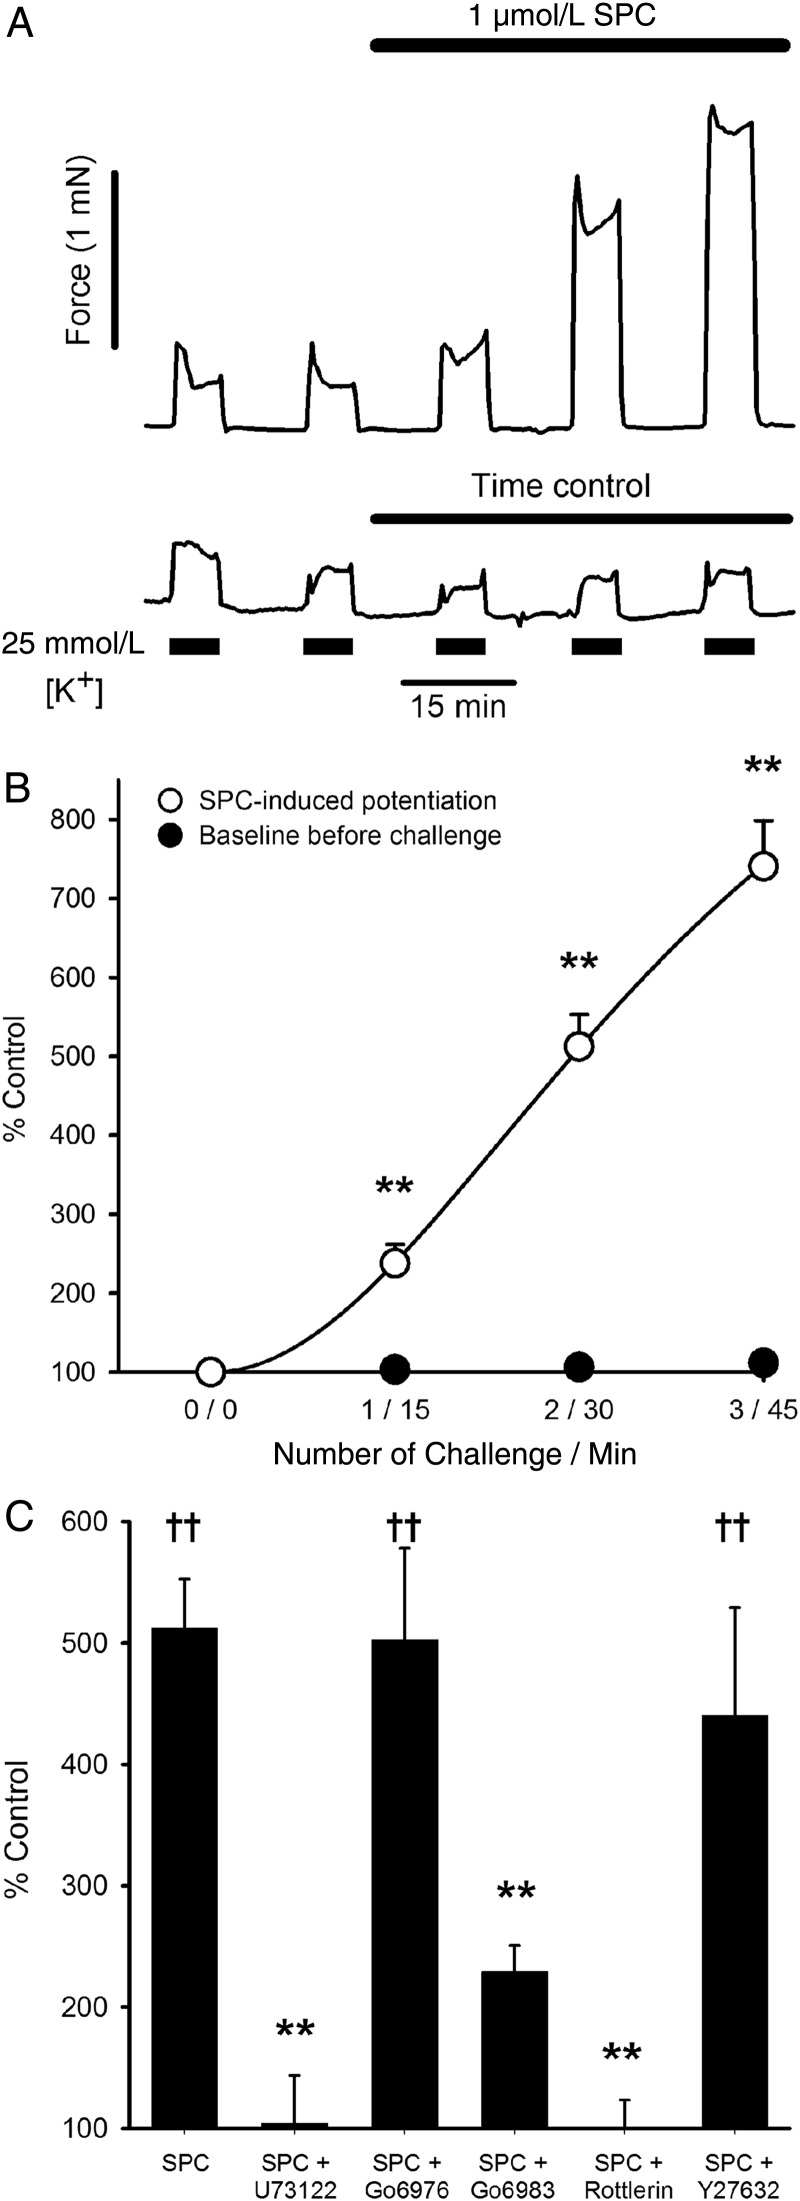
SPC-induced potentiation of tension development in MA. (A) Typical recordings of tension developed in rat MA to 5 min challenges with PSS containing 25 mmol/L [K+], demonstrating strong potentiation of contraction following addition of 1 µmol/L SPC compared with time control. (B) Mean data from 31 MAs (24 rats). Open symbols represent an increase in tension over control response (challenge 0 at time 0, i.e. 0 / 0) following addition of SPC. Filled symbols represent tension immediately preceding each depolarizing challenge, demonstrating a stable baseline. Bars = SEM, where not shown, smaller than symbol. ** P < 0.001 vs. control; repeated measures (RM) ANOVA on ranks, Tukey post hoc. (C) SPC-induced potentiation in MA from 24 rats at 30 min (challenge 2) in the presence of U73122 (PLC inhibitor, n = 4), Go6976 (conventional PKC inhibitor, n = 7), Go6983 (broad-spectrum PKC inhibitor, n = 6), rottlerin (putative PKCδ inhibitor, n = 5), and Y27362 (Rho kinase inhibitor, n = 7). Bars = SEM. **P < 0.001 vs. SPC alone; ††P < 0.001 vs. control; two-way ANOVA, Holm-Sidak post hoc.